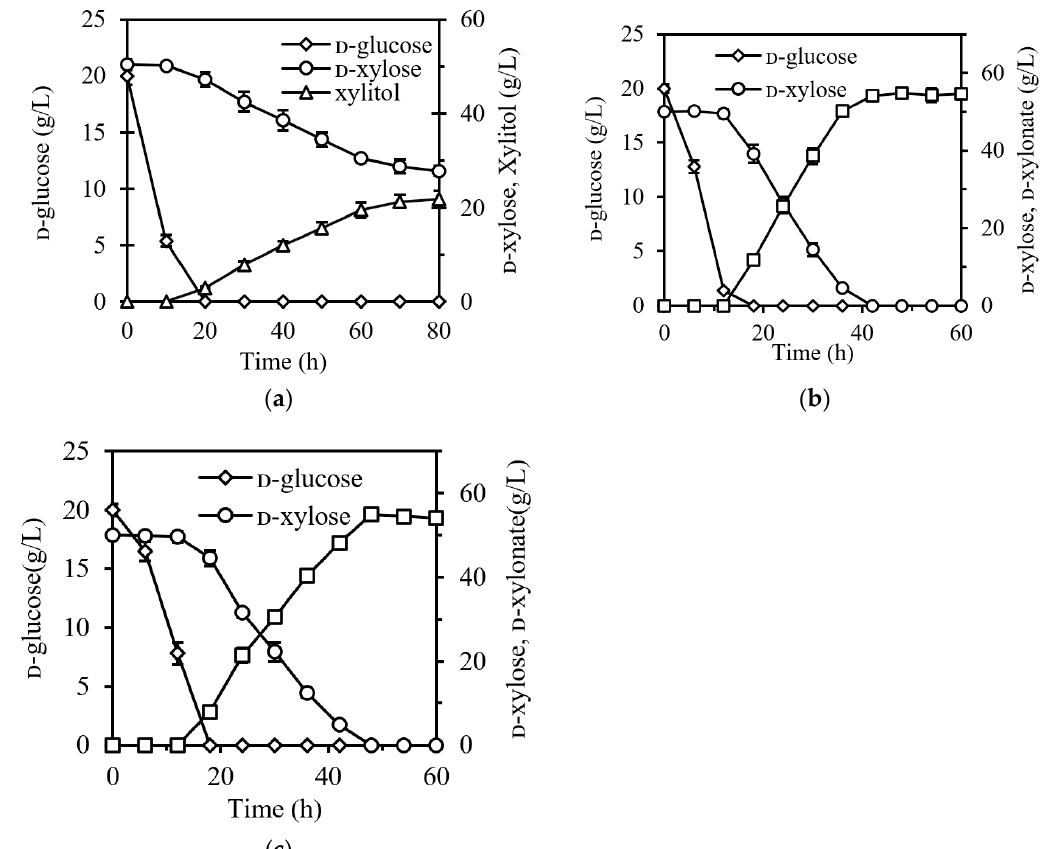
Figure 1. Time course of xylitol and ᴅ -xylonate production in the YPD medium containing 50 g/L ᴅ -xylose. ( a ) Xylitol production of P. kudriavzevii N-X. ᴅ -xylonate production of P. kudriavzevii N-X/S1 at initial pH 5.5 ( b ) and pH 3.0 ( c ), respectively. Error bars represent ± SD.